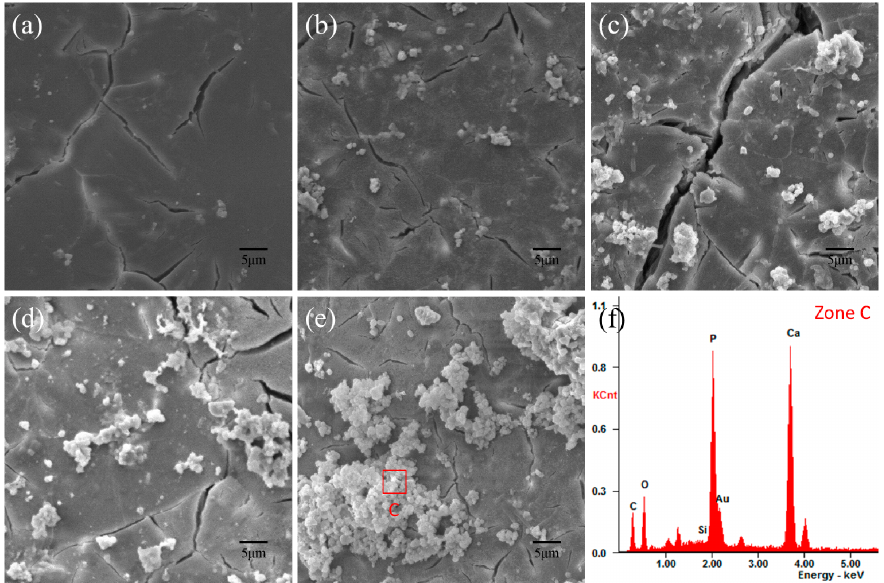
Figure 7. SEM surface morphologies of the ( a ) PHBV; ( b ) PHBV/5%CS; ( c ) PHBV/10%CS; ( d ) PHBV/15%CS and ( e ) PHBV/20%CS scaffolds after being immersed in SBF for 14 days; ( f ) The EDS spectrum of deposits in Zone C.